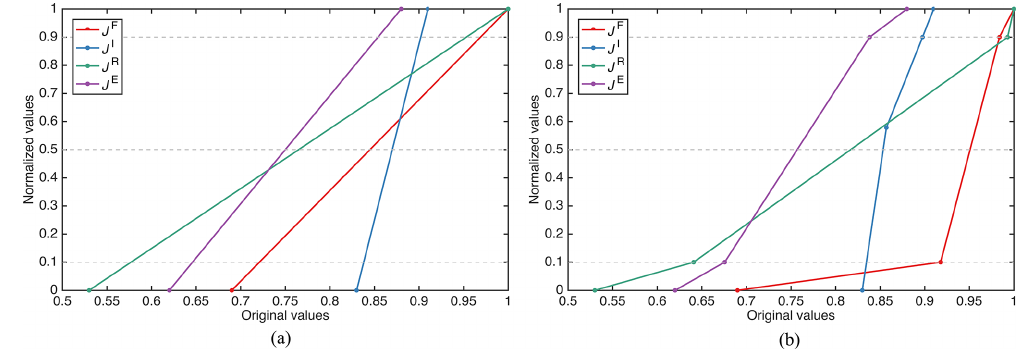
Figure 2. Linear (a) and non-linear (b) value functions of J F , J I , J R , and J E in the formulation of the equity index.